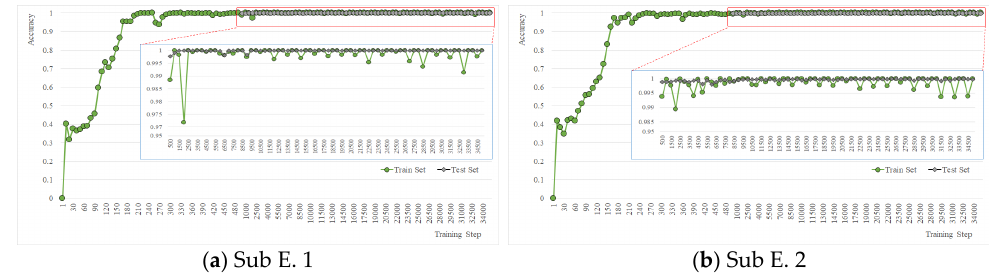
Figure 15. Accuracy of experiment 2 (three-class).